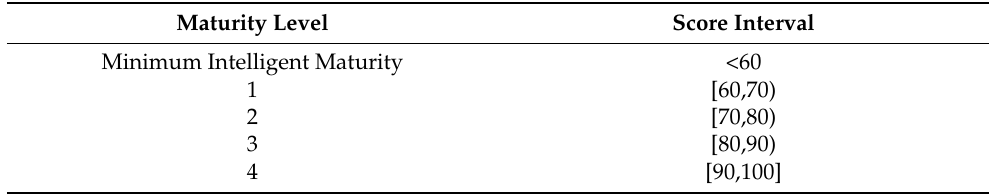
Table 8. Maturity levels and corresponding score intervals. Maturity